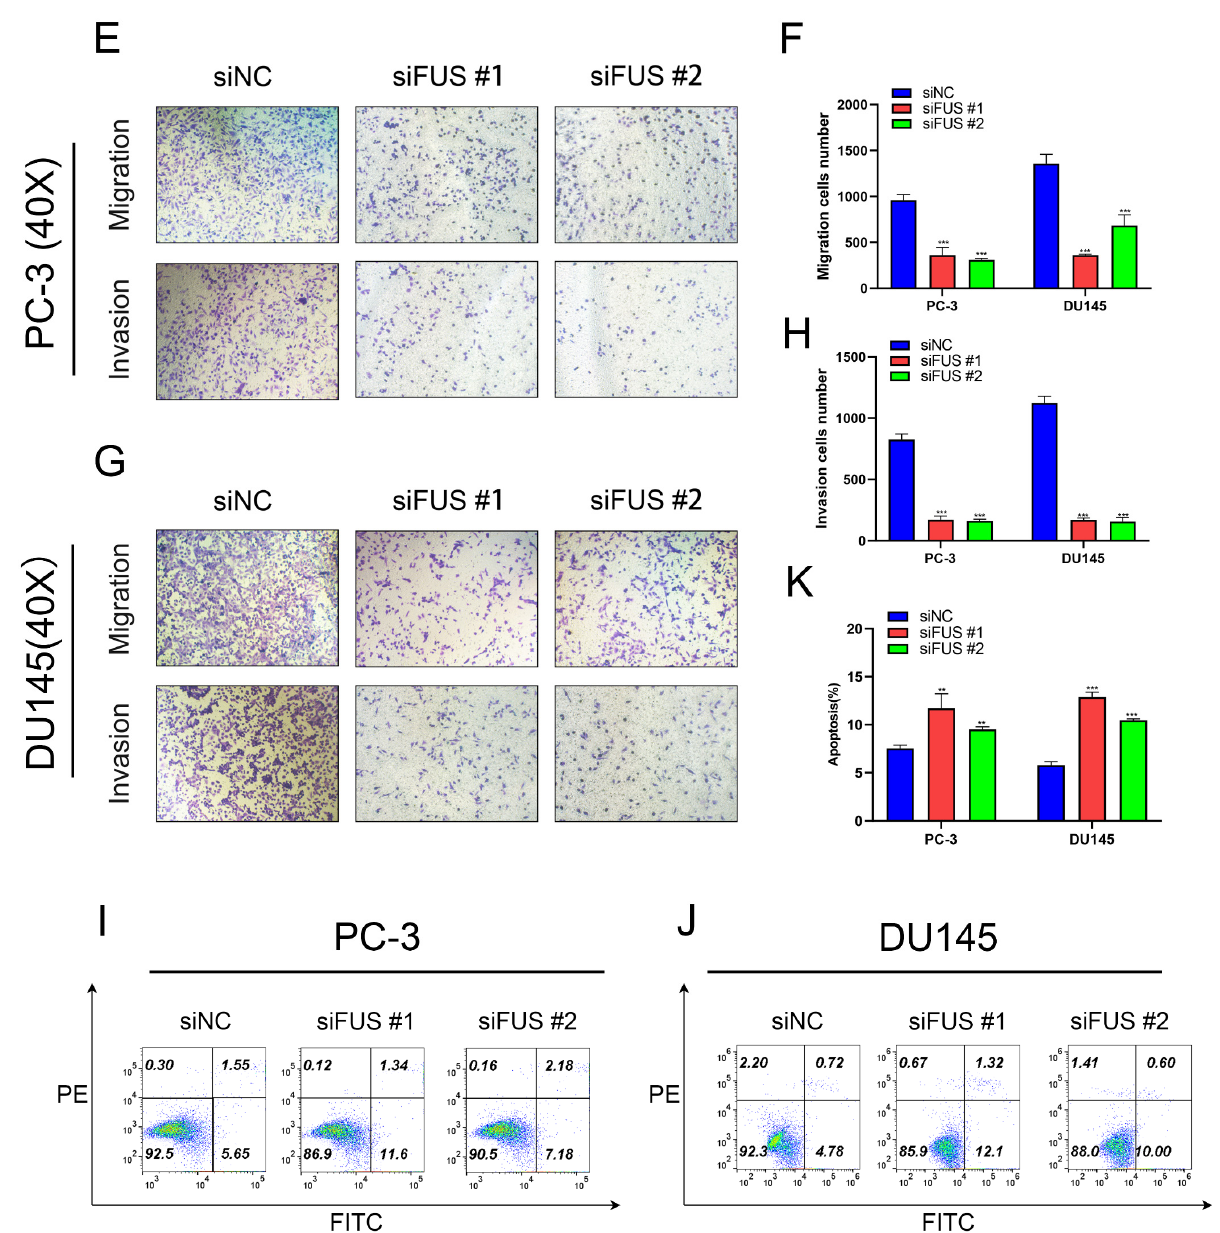
Figure 8. The biological function of FUS in the abilities of proliferation, migration, invasion, and apoptosis of PCa cells. The interference efficiencies of FUS in PC-3 and DU145 cells by siRNAs were verified by qRT-PCR ( A ) and Western blot ( B ). CCK-8 assays demonstrated the inhibition of FUS inhibit the proliferation ability of PC-3 and DU145 cells ( C , D ). Transwell assays indicated the depletion of FUS significantly blocked the migration and invasion ability of PC-3 and DU145 cells ( E – H ). The flow cytometric assay revealed that the inhibition of FUS could conspicuously promote apoptosis of PC-3 and DU145 cells ( I – K ). **: p < 0.01; ***: p < 0.001.